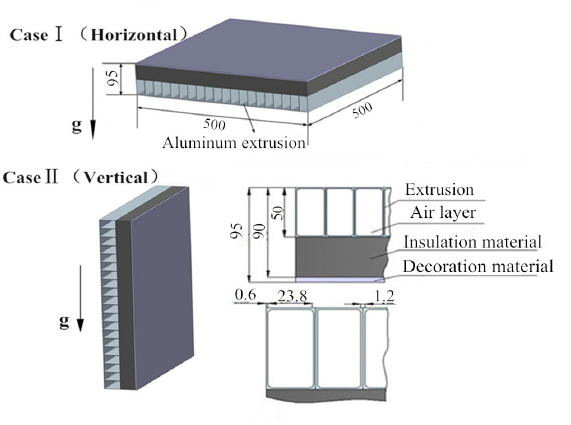
Fig. 2. Two cases with different positions regarding to the gravity and the configurations of the test